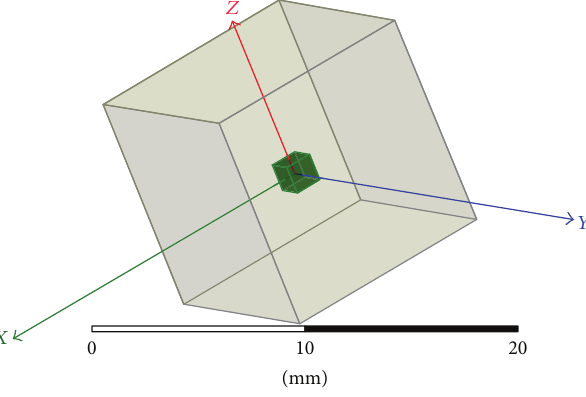
Figure 1: The simulation model of dielectric ceramic cube by 2 × 2 × 2 mm.